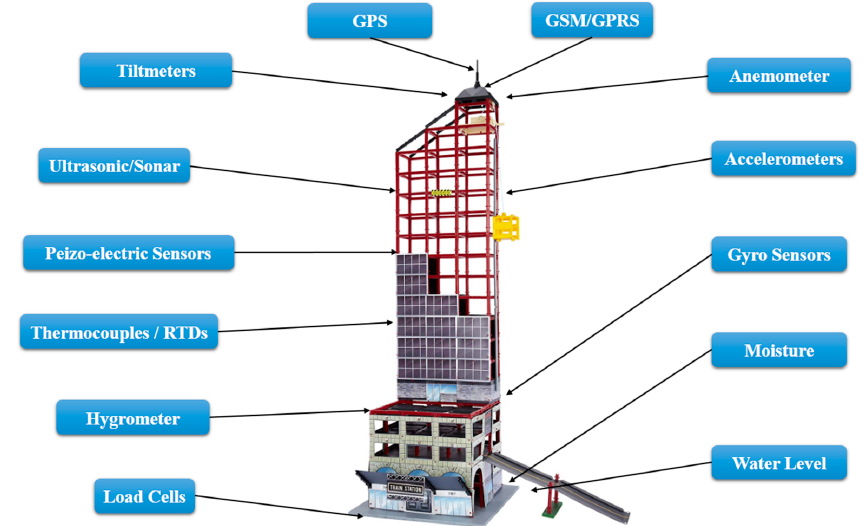
Figure 3. SHM system level of Detail 6 from BIS documentation.